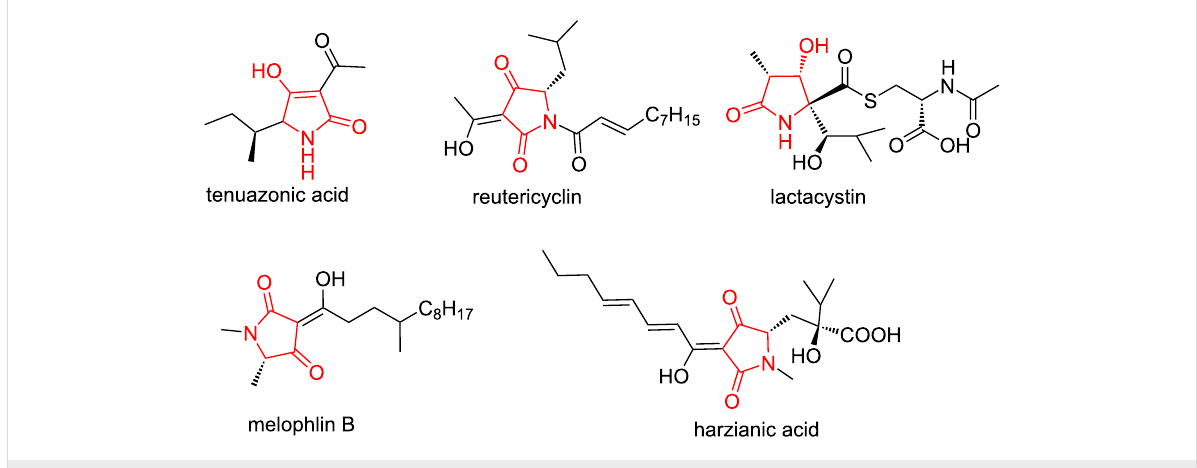
Figure 1: Structures of natural tetramic acid derivatives with more clinical